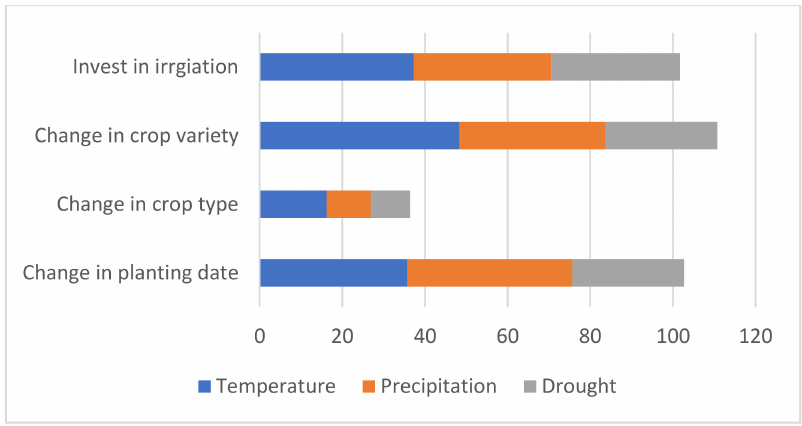
Figure 1. Adoption of adaptation options to changes in climatic